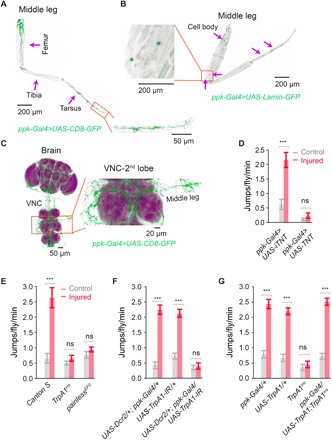
TrpA1 is required in ppk+ sensory neurons for allodynia after injury.(A) ppk+ sensory neuron projections in the fly leg, labeled with CD8-GFP, n ≥ 7. (B) ppk+ cell bodies in the leg, labeled with Lamin-GFP, n ≥ 7. (C) ppk+ sensory neuron projections from the dissected leg to the VNC and brain. (D) Expression of active tetanus toxin (TNT) but not inactive tetanus toxin (iTNT) in ppk+ sensory neurons blocked all adult thermal nocifensive behavior (n = 9 animals, 10 animals per replicate). (E) TrpA1 and painless mutants are resistant to thermal allodynia (38°C) (n = 9 replicates, 10 animals per replicate). (F) TrpA1 is specifically required in ppk+ sensory neurons for allodynia after injury (n = 9 replicates, 10 animals per replicate). (G) Reintroduction of TrpA1 specifically in ppk+ sensory neurons rescue allodynia response (n = 9 replicates, 10 animals per replicate). Data are represented as means ± SEM. ***P < 0.001; two-way ANOVA followed by Tukey’s post hoc test.